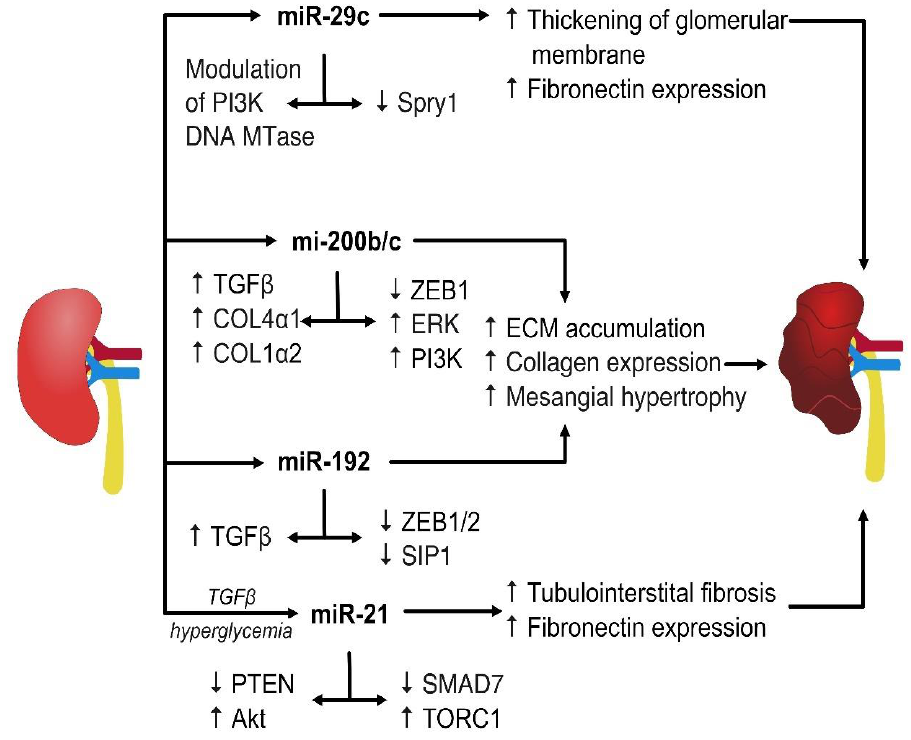
Figure 1. The miRs are involved in numerous molecular pathways contributing to DN. The most common involve upregulation of TGF-β1 and collagen synthesis or downregulation of PTEN.